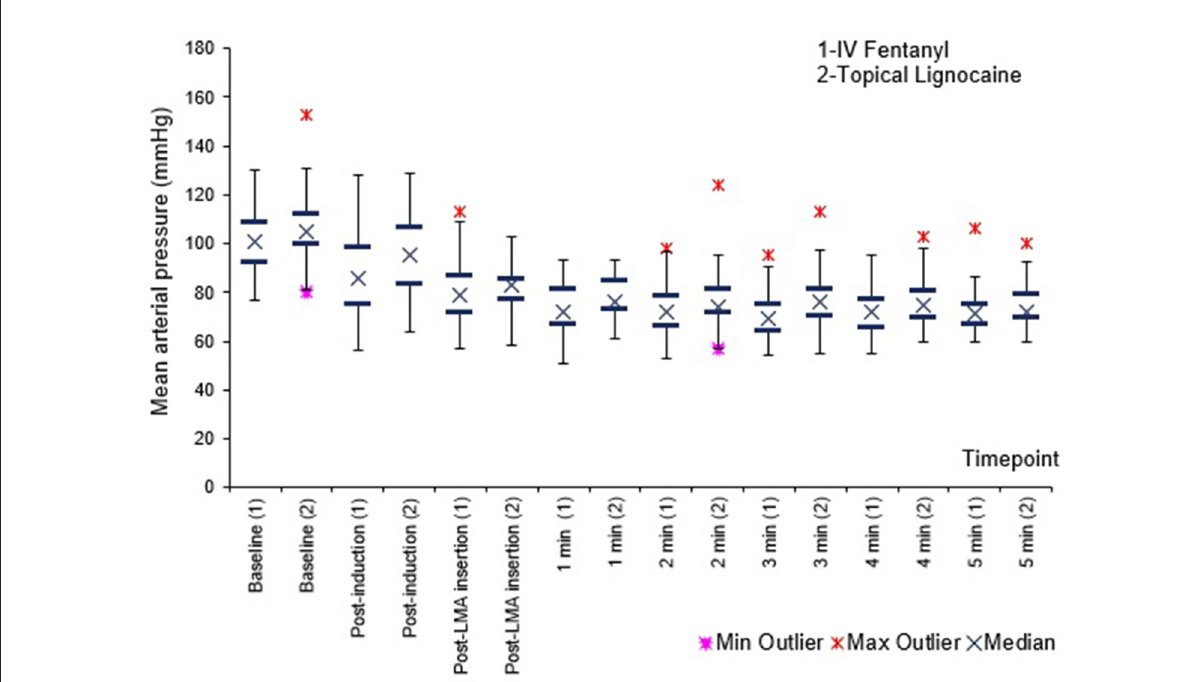
FIGURE3 Mean arterial pressure (MAP) before, immediately after, and 1–5min after PLMA insertion. Results presented as median, 25 and 75th percentile, minimum and maximum values.